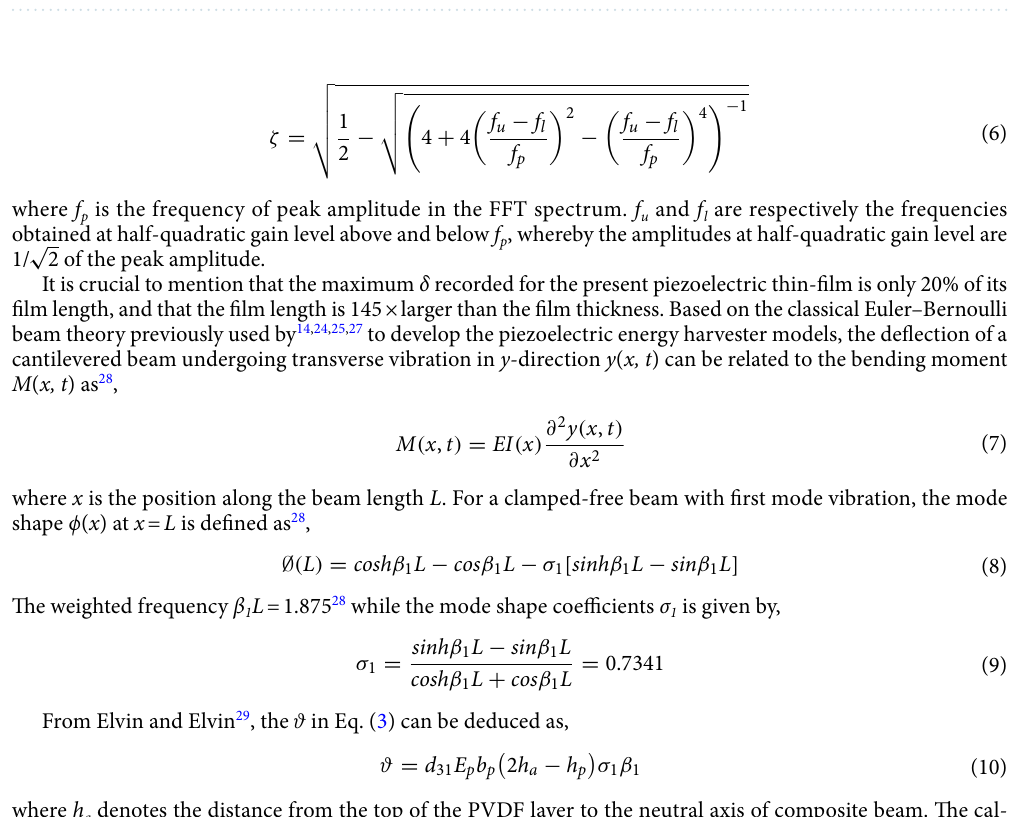
Table 3. SDOF piezoelectric beam parameters. Superscript [m] denotes experimentally measured